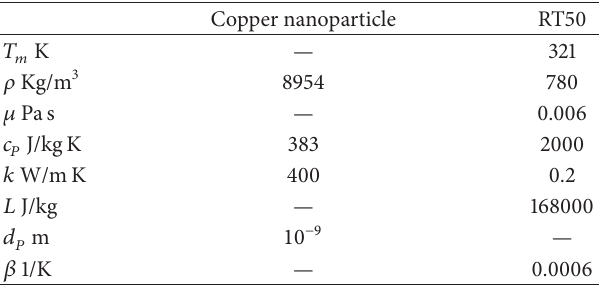
Table 1: Thermophysical properties of the copper nanoparticle and